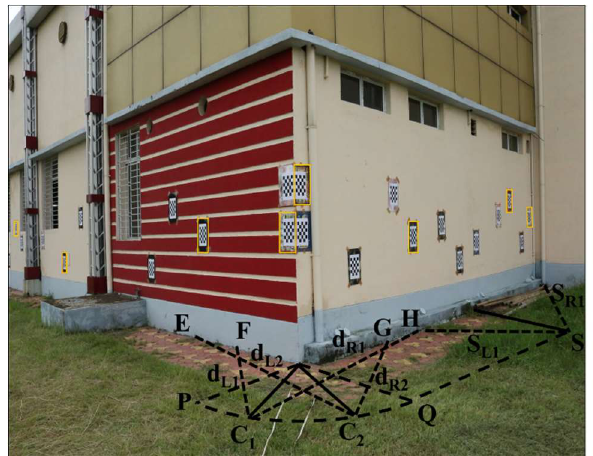
Figure 1. Image acquisition by convergent and normal geometries for a building corner and wall Images acquired at camera positions C 1 and C 2 are examples of convergent geometry, whereas normal geometry image is acquired at camera position S. The camera optical axis at C 1 and C 2 are pointing at building corner. However, at S optical axis of camera is perpendicular to wall. For the normal geometry, GSD varies symmetrically from the centre to both ends of an image as the distances from camera to wall, S L1 and S R1 , are equal. On the other hand, for convergent geometry (at C 1 and C 2 ), distances, d L1 , d R1 , d L2 , and d R2 are different even the images are acquired at same distance from the building corner. Figure 2 below shows normal geometry capturing a building